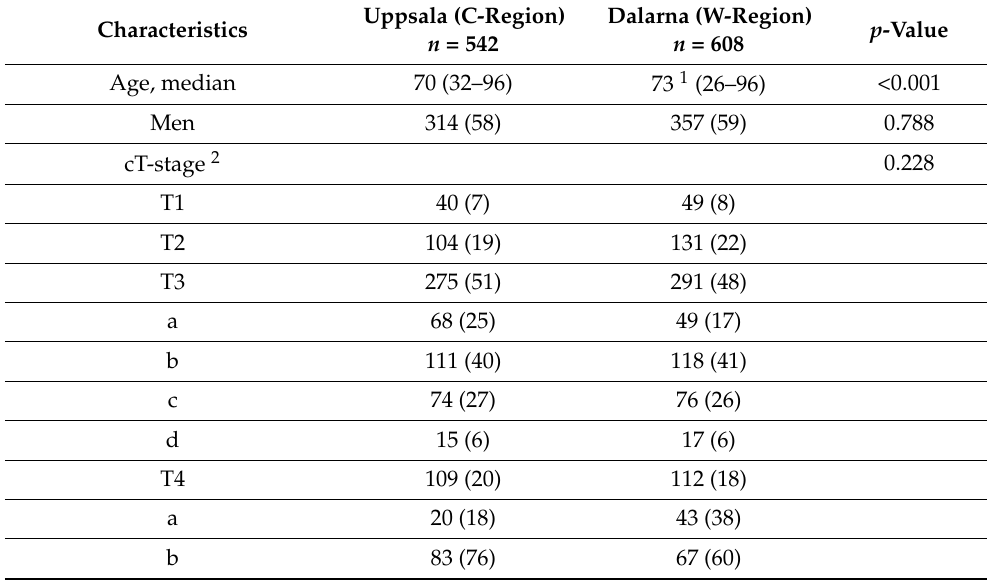
Table 1. Characteristics at baseline and chosen initial treatment for patients without distant metasta- sis